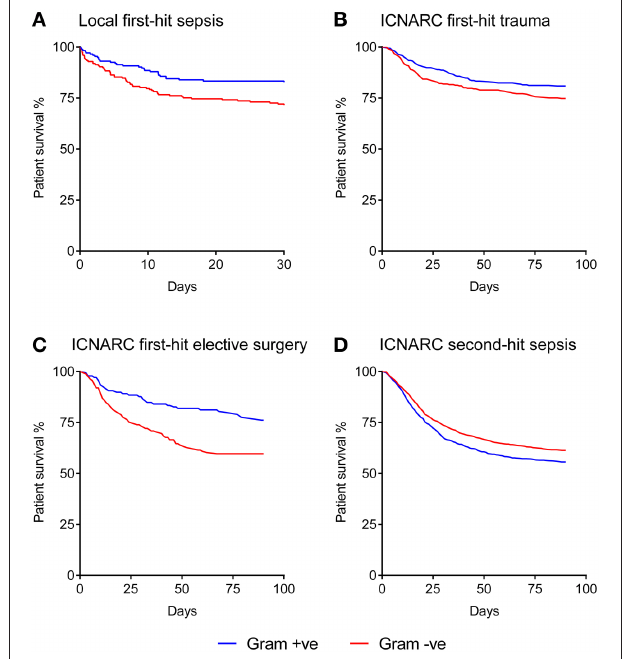
FIGURE 1 | Kaplan-Meier analysis of sepsis patient survival according to Gram status of the causative organism. (A) Local dataset of first-hit sepsis patients ( n = 371 ). (B) ICNARC dataset of first-hit trauma patients developing a unit-acquired infection ( n = 703 ). (C) ICNARC dataset of first-hit elective surgery patients developing a unit-acquired infection ( n = 616 ). (D) ICNARC dataset of second-hit sepsis patients subsequently developing a unit-acquired infection ( n = 2131 ). All Gram differences are significant using the Mantel-Cox (Log-rank) test at p < 0.01